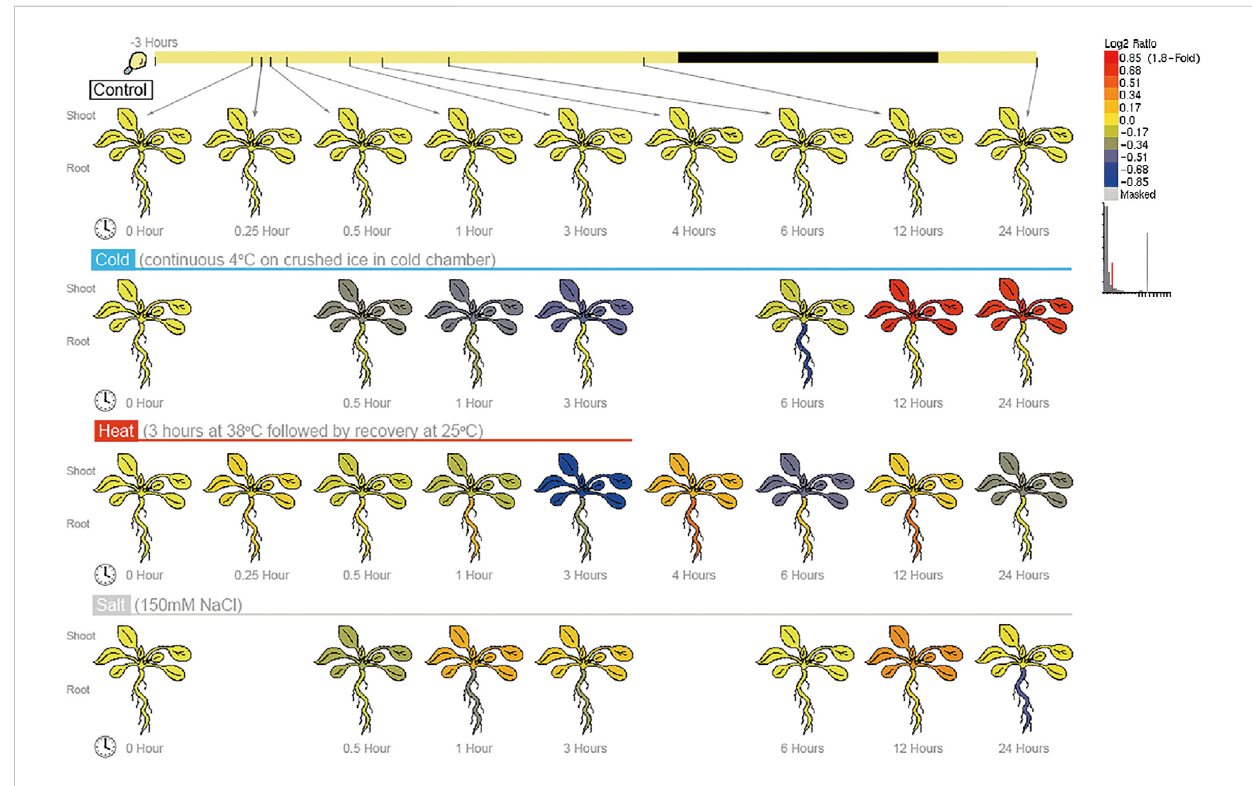
FIGURE 6 Expression of BPC6 gene under different abiotic stresses.